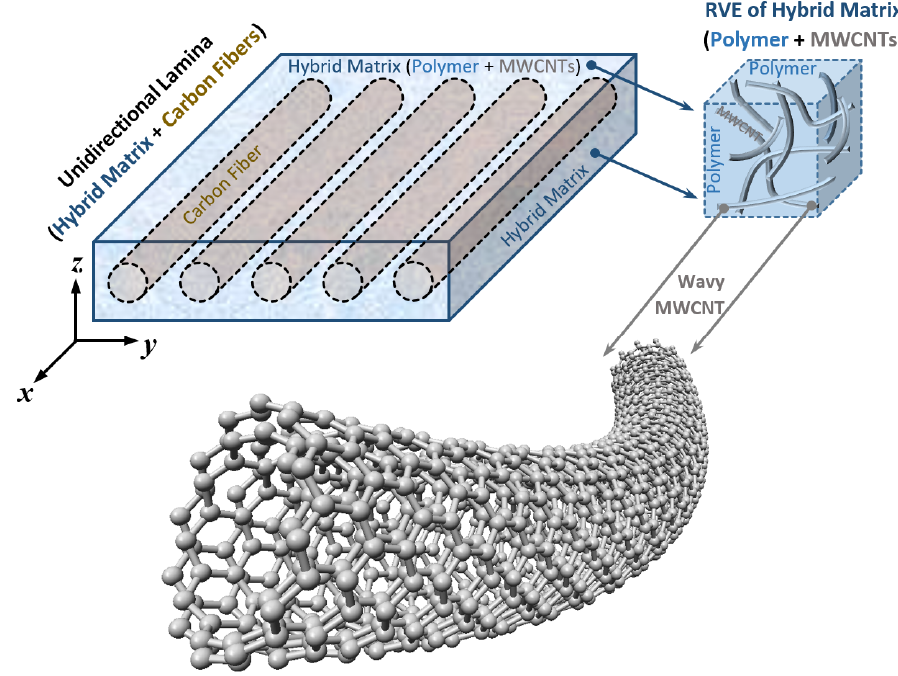
Figure 1. Unidirectional fiber ‐ reinforced composite lamina with MWCNT inclusion.